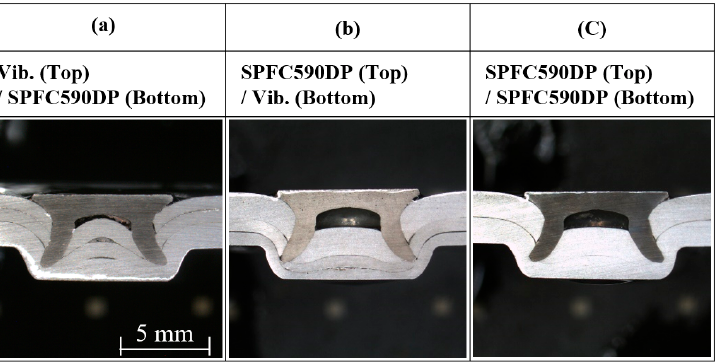
Figure 8. Comparison of the cross-sectional images of self-piercing riveted joints (fabricated by type A1 die) for di ff erent panel stacking combinations. ( a ) Vibration-damping steel (top) and SPFC590DP (bo tt om), ( b ) SPFC590DP (top) and vibration-damping steel (bo tt om), and ( c ) SPFC590DP (top) and SPFC590DP (bo tt om).